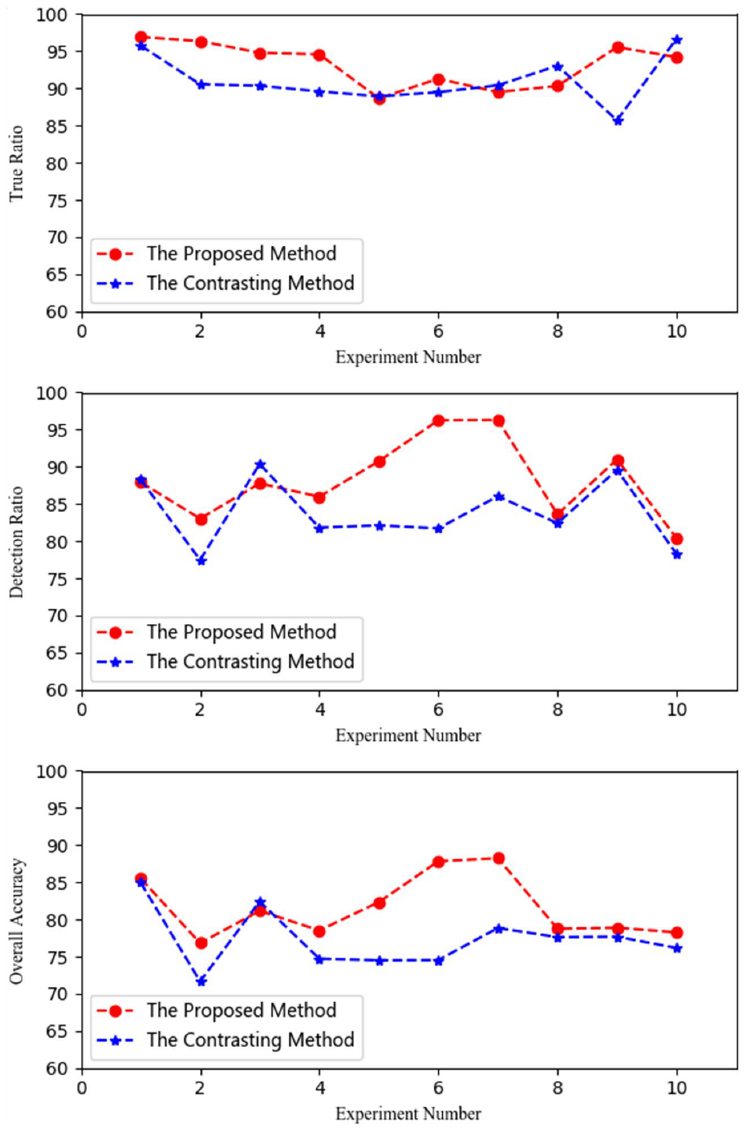
Figure 7. A comparison between the metrics for the proposed method and those for the Figure contrasting methods.